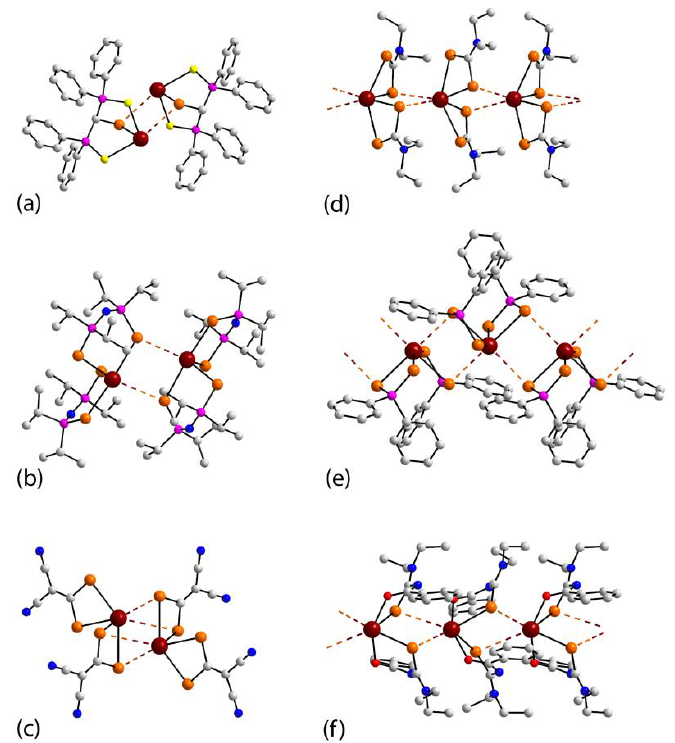
Figure 5. Supramolecular aggregation via Pb ··· Se secondary bonding in ( a ) 14 {UTAJUV; d(Pb ··· Se) = 3.41 Å}, ( b ) 15 {TAKLOI; 3.57 Å}, ( c ) 16 {KUHSAH; 3.49 & 3.72 Å}, ( d ) 17 {BOKMUJ; 3.47 & 3.62 Å}, ( e ) 18 {XUZTUI; 3.27 & 3.40 Å}, and ( f ) 19 {YIBHOG; 3.64 Å}. Additional color code: phosphorus, pink.